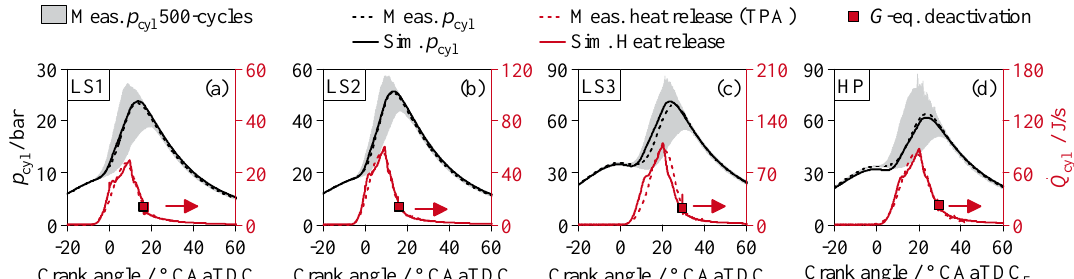
Figure 6. Comparison of measured and simulated pressure curves ( p cyl ), as well as the heat release rate ( ˙ Q cyl ) obtained from three-pressure analysis (TPA) [41] and simulation. Operating points: ( a ) LS1, ( b ) LS2, ( c ) LS3, ( d ) HP.